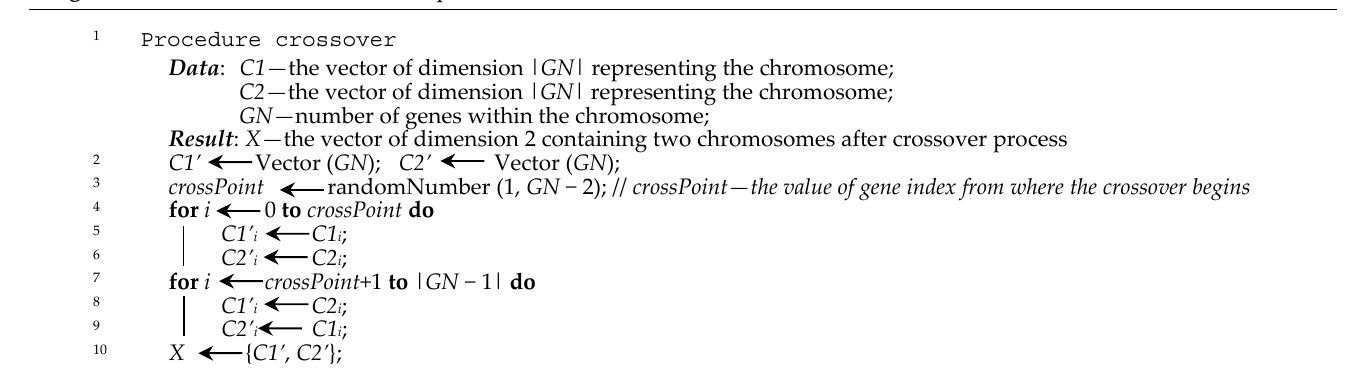
Algorithm 3. Pseudo code of crossover process. Procedure